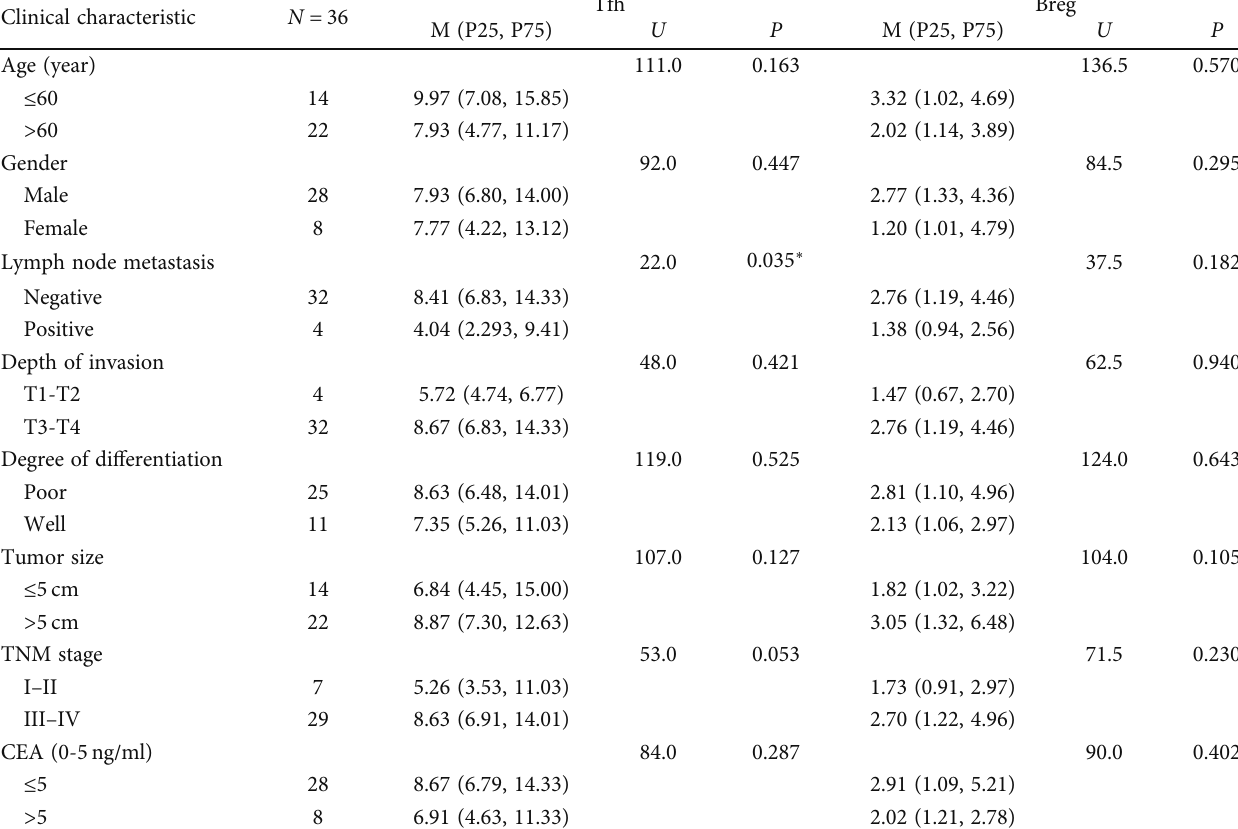
Table 1: Association between Tfh, Breg and clinical characteristics of gastric cancer